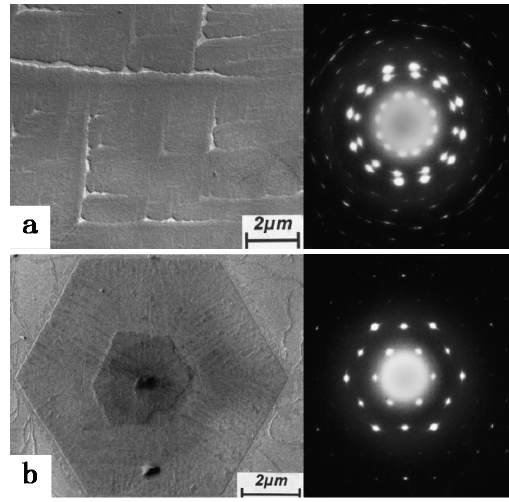
Figure 3. Bright field electron micrographs and corresponding diffraction patterns of iPBu form I crystals converted from form II ( a ) and crystallized directly from the melt ( b ). The sample used for ( a )